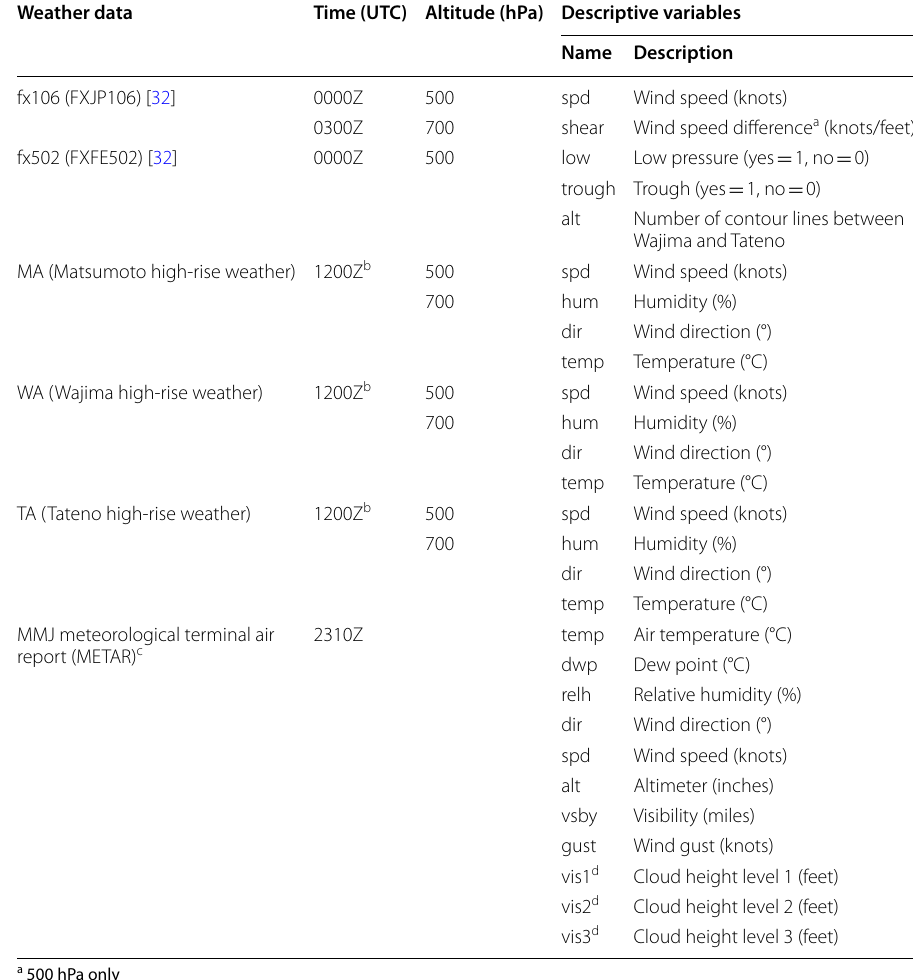
Table 3 List of data